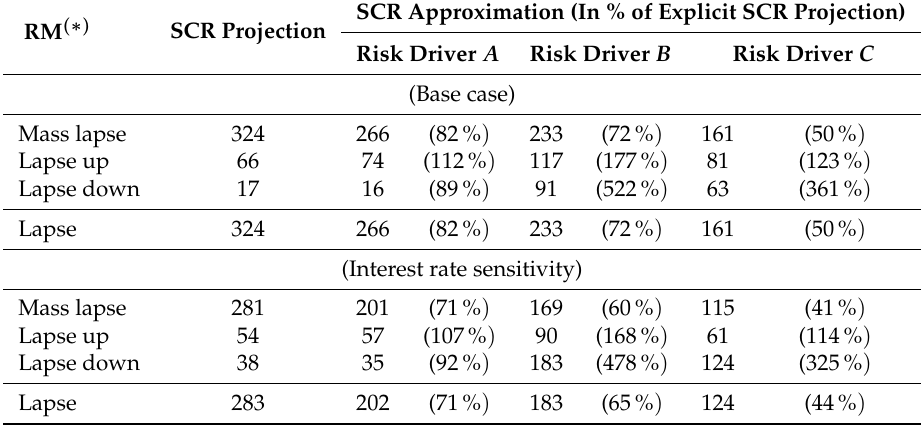
Table 10. Cost-of-capital RM ( ∗ ) resulting from projected and approximated SCRs (in A